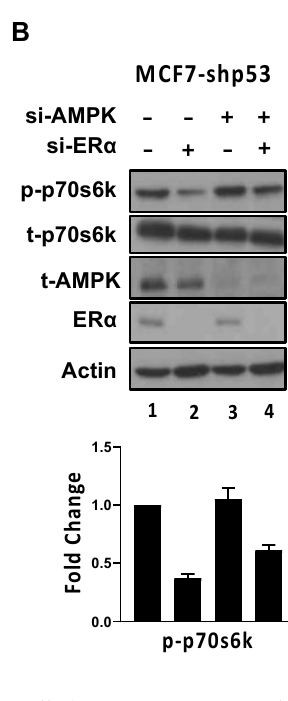
Figure 3. ER α and p53 regulate mTOR pathway. MCF7 isogenic cells (MCF-wtp53, MCF7-shp53, and MCF7-mutp53) differing in their p53 mutational status were treated with ( A ) siRNA targeting ER α (25 nM) for 48 h. ( B ) MCF7-shp53 cells were treated with siRNA targeting ER α (25 nM) or AMPK α 1/2 (50 nM) or both for 48 h. Subsequently, cells were lysed, and immunoblotting analysis was performed probing for p-p70s6k (a downstream target of mTOR activation), total p70s6k (t-p70s6k), p-AMPK, total AMPK (t-AMPK), ER α , and p53. Representative blots for actin are shown. Quantitation of t-p70s6k, ER α , and AMPK protein expression levels are shown in Figure S3A,B. Panel below immunoblot ( A ) represents graphed densitometric analysis of p-p70s6k levels normalized to actin and then to non-specific silencing siRNA treatment of the wild type p53 expressing condition. Panel below immunoblot ( B ) represents graphed densitometric analysis of p-p70s6k levels normalized to actin and then to non-specific silencing siRNA treatment. Values reflect mean ± standard deviation of two-three biological